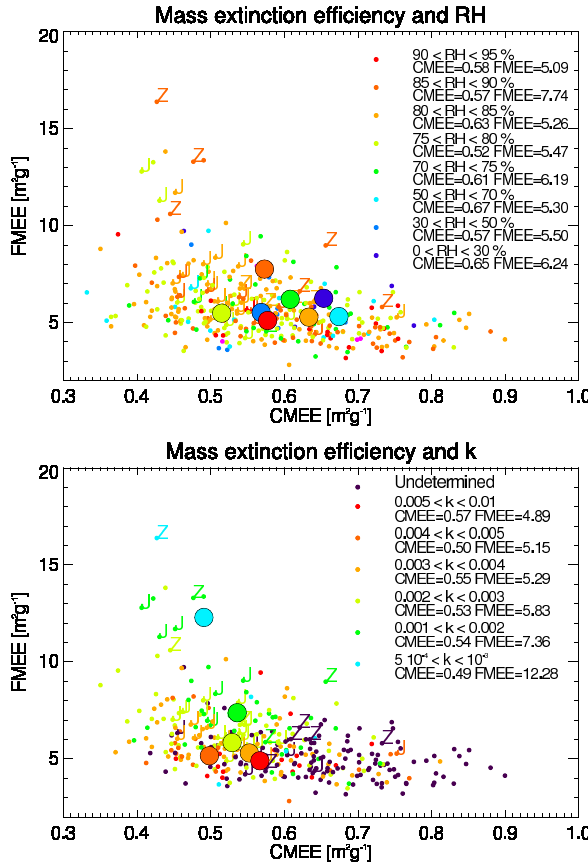
Fig. 6. Daily mass extinction efficiency (m 2 g − 1 ) for coarse (CMEE) and fine (FMEE) modes at all AERONET stations from April 2009 to March 2010 when the Angstrom exponent is less than 0.5, and as a function of relative humidity at 925mb (upper panel) and AERONET imaginary part of refractive index at 670nm (lower panel). The range of RH and k values and the corresponding mean values of FMEE and CMEE, in units of m 2 g − 1 are provided on the upper right of each panels. The Zinder Airport and Jaipur AERONET sites are indicated by the letter Z and J,